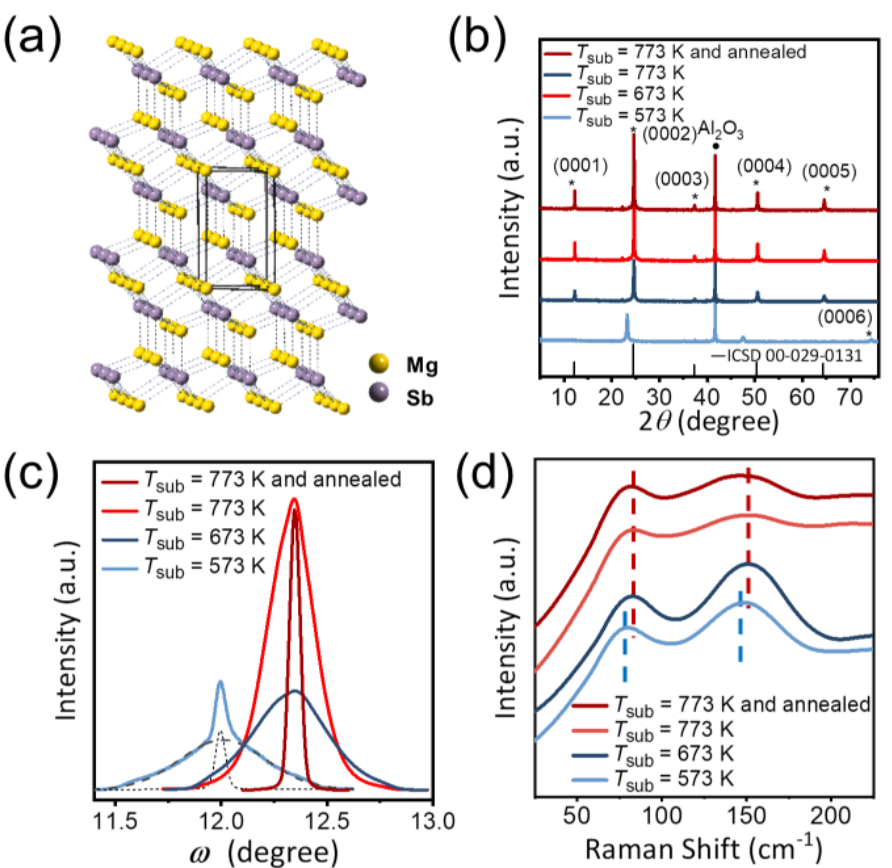
Figure 1. ( a ) Crystal structure of Mg 3 Sb 2 drawn based on the tetragonal structure (space group R-3m, a = b = 4.55 Å, c = 7.23 Å), with comparable interlayer and intralayer bonds; ( b ) θ - 2 θ XRD patterns for the Mg 3 Sb 2 films grown on Al 2 O 3 (000 l ) substrates under different thermal processes. The Mg 3 Sb 2 film grown at 573 K is submitted to a 5.4% tensile strain along the c -axis; ( c ) Rocking curves around the (0002) reflection of the grown Mg 3 Sb 2 films in ( b ). The film grown and in situ annealed at 773 K exhibits the highest crystallinity and the lowest dislocation density, with FWHM = 0.12°. ( d ) The Raman spectra of the Mg 3 Sb 2 films; the positions of the Raman peaks are marked with dotted lines.